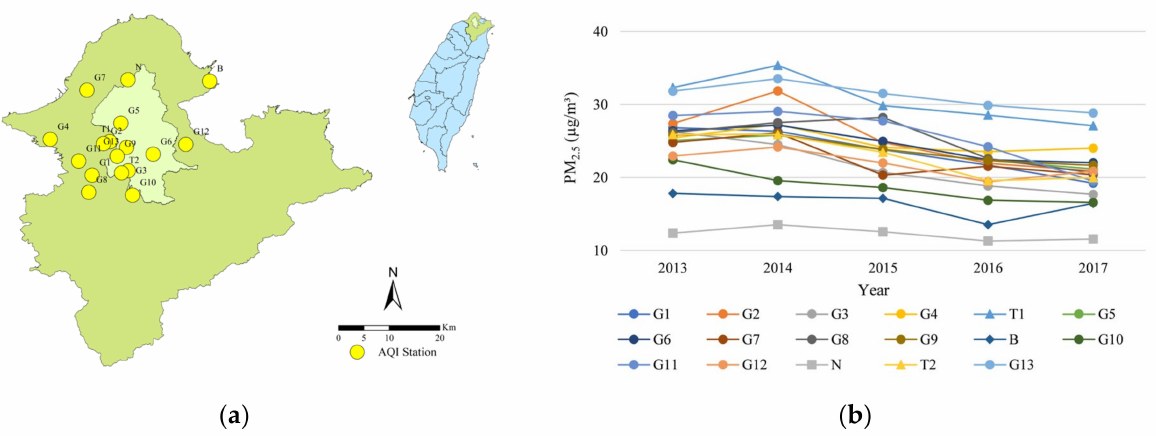
Figure 1. Study area and PM 2.5 monitoring stations. ( a ) Locations of the study area (Taipei Metropo- lis) and PM 2.5 monitoring stations. ( b ) Time series of the PM 2.5 concentrations from 2013–2017 (17-monitoring